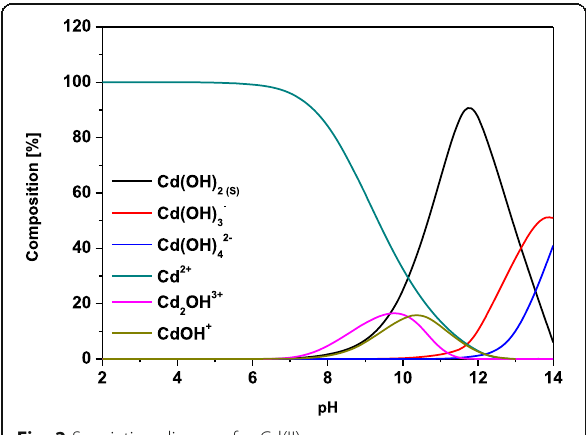
Fig. 2 Speciation diagram for